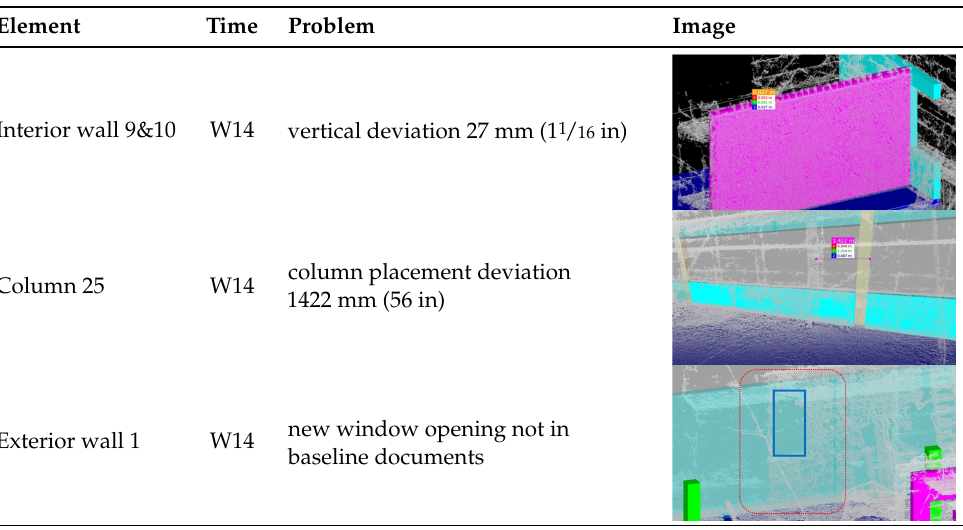
Table 5. Quality monitoring result.